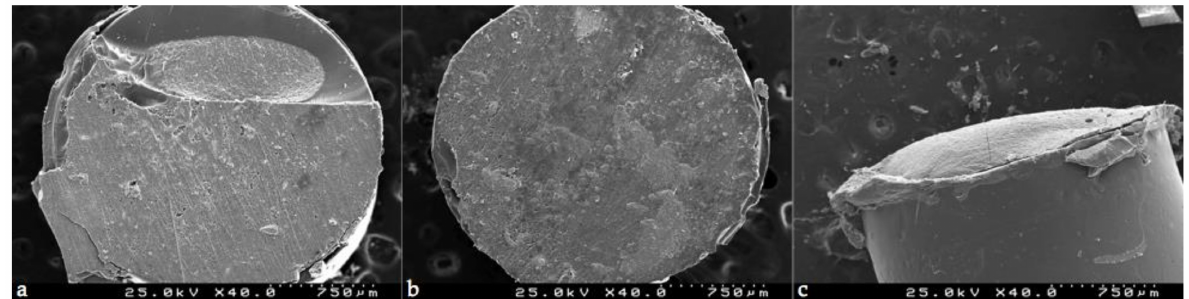
Figure 2. Scanning electron microscope images of mixed fracture ( a ), adhesive fracture ( b ) and cohesive fracture in CSC ( c ) (original magnification 40 × ).